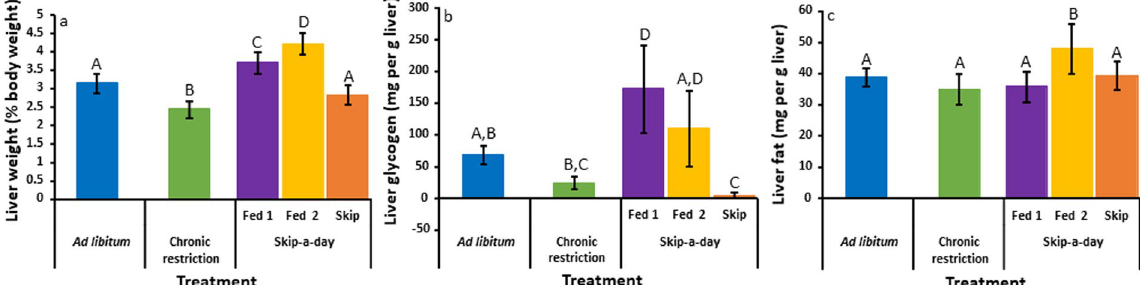
Figure 4. The characteristic weights ( a ), glycogen contents ( b ) and fat contents ( c ) of livers from Red Junglefowl chicks reared under ad libitum feeding (blue, N = 6), chronic feed restriction (Green, N = 6) and skip-a-day feeding consisting of a first fed day, Fed 1 (purple, N = 5), a second fed day, Fed 2 (yellow, N = 4) and a skipped day without food (orange, N = 7). Liver weights are shown as a percentage of body weight, liver constituents are shown as mg per g of liver. Error bars represent standard deviations of the mean. Significant differences (determined using two-way ANOVA, p < 0.05) are indicated with different letters.